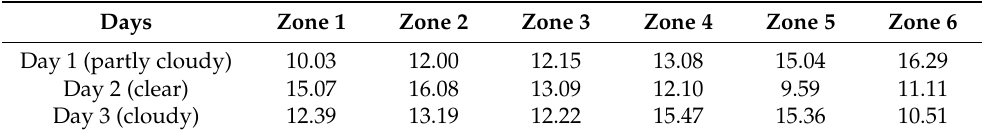
Figure 1. Setup of the experimental field. ( A ) Horizontal zones delimitated by red dashed lines (1-2-3); ( B ) longitudinal zones delimitated by red dashed lines (4-5-6); and ( C ) nine ground control points (red dots) and the central part of the agricultural field sampled with 300 random points (blue dashed rectangle). Table 1. Experimental setup: Weather conditions over the three days and daytimes of the flights over the six zones (Figure